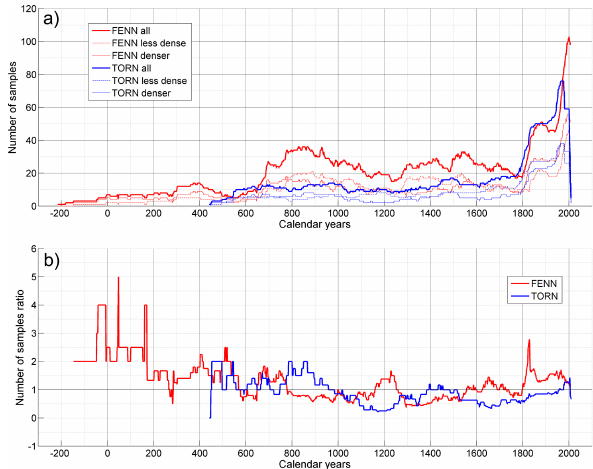
Figure 2. Sample replication for FENN and TORN full data sets, denser and less dense cohorts (trees with higher and lower average MXD values for the first 100yr) (a) and ratios between replications of denser and less dense cohorts for TORN and FENN data sets (b)